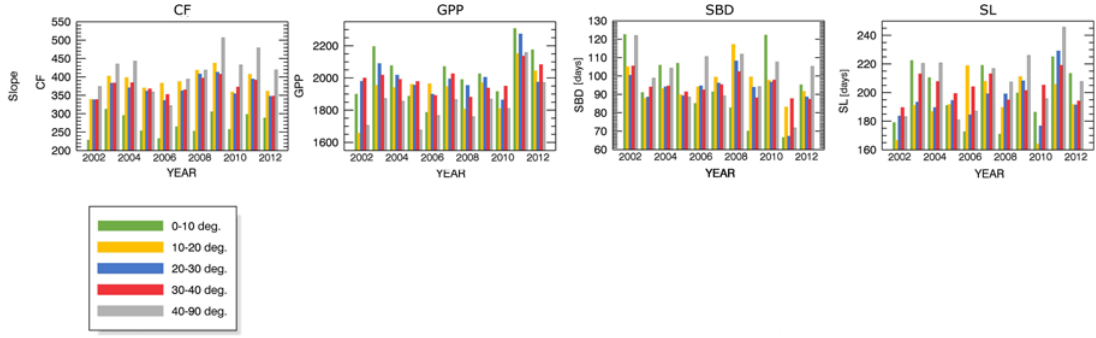
Figure A1. Marginal means plots of repeated measures ANOVA showing CF, GPP, SBD and SL variability in relation to slope. Analyses performed for the 4nNDII7 drought impact class 3 spatial footprint. Abbreviations are explained in Table A1.